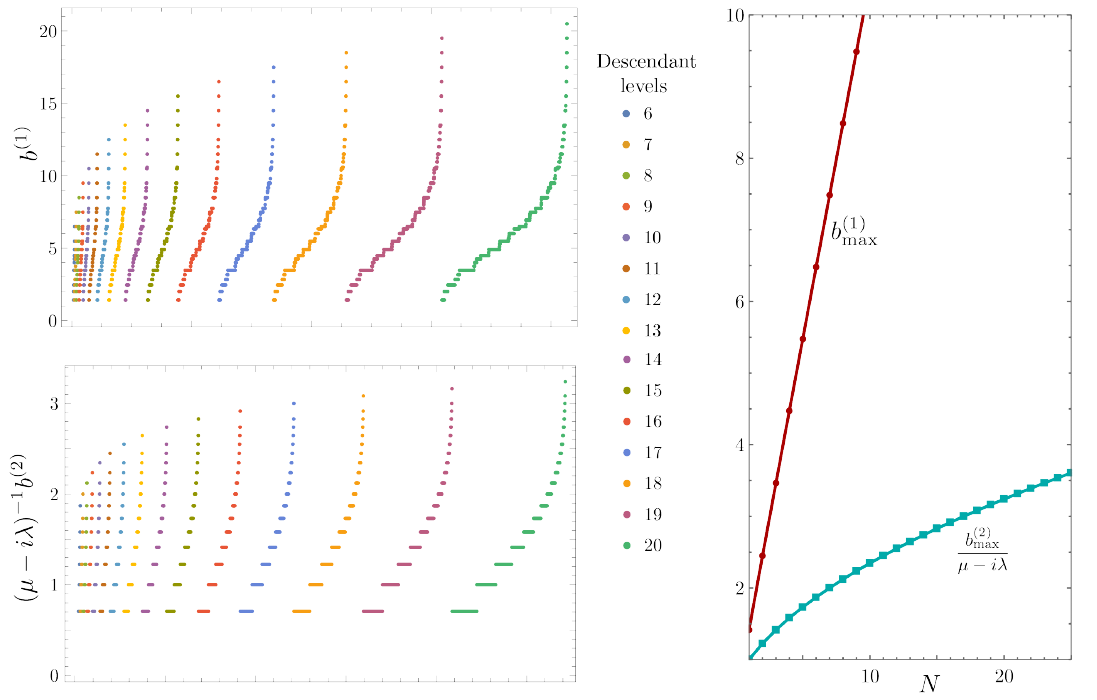
Figure 5 . [Left] Plots of type-1 and type-2 Lanczos elements eqs. (3.5) and (3.6) from descendant levels 6 to 20. We have set α = 1 and the data for each descendant level is sorted in the ascending order. [Right] Maximum values of the Lanczos element from each descendant level while the maximal type-1 elements have an asymptotic linear growth, while the maximal type-2 elements have growth. These are derived analytically in eqs. (3.10) and